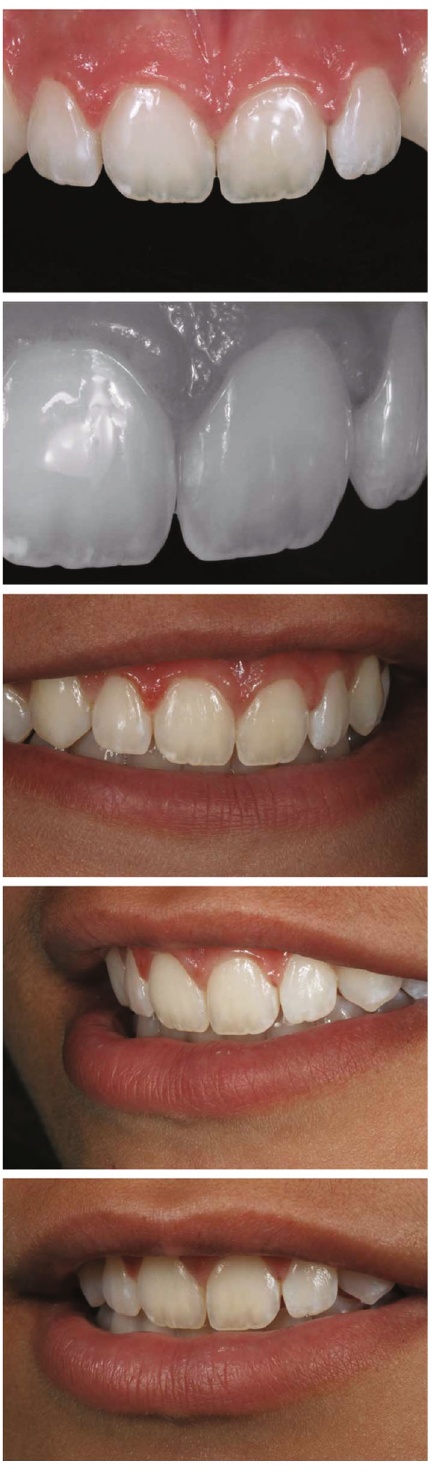
Figure 9: Final aspect of the upper anterior teeth. Note the color harmony provided by the association of enamel macroabrasion and partial veneer in composite